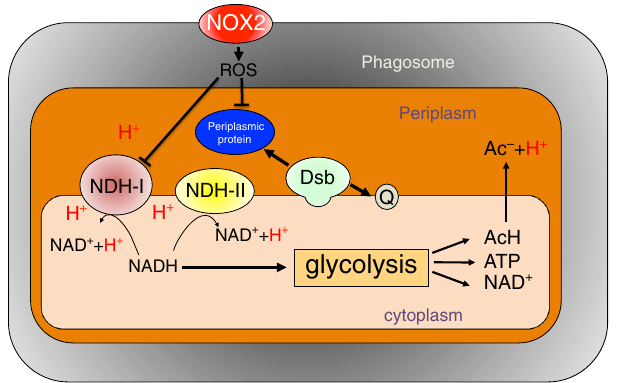
Fig. 5 Model for the metabolic adaptations that ameliorate NOX2 killing of intracellular Salmonella . Reactive oxygen species (ROS) produced by NOX2 in the phagosome target the proton-coupled NDH-I isoform of NADH dehydrogenase of Salmonella . Oxidative stress also diminishes transcription of nuo genes encoding NDH-I. Together, the negative effects oxidative stress has on the expression of NDH-I contributes to the dissipation of Δ pH across the bacterial membrane. Collapse of Δ pH negatively impacts the function of the oxidoreductase Dsb system, which introduces disul fi de bonds among in cysteine residues of periplasmic proteins (blue). Collapse of Δ pH, defective Dsb function and oxidation of cell envelope proteins catastrophically synergize to mediate NOX2- dependent killing of intracellular Salmonella . In response to the selective pressure oxidative stress imposes on the ETC, Salmonella shuttles of NADH reducing power to fermentation, thereby not only diminishing electron fl ow through ETC but also allowing for proper folding of periplasmic proteins by Dsb oxidoreductases that delivered the extracted reducing power into the quinones (Q) of the ETC. Fermentation of glucose also provides ATP synthesis by substrate-level phosphorylation, balances NAD + /NADH, and helps maintain Δ pH across membrane via dissociation of products such as acetic acid